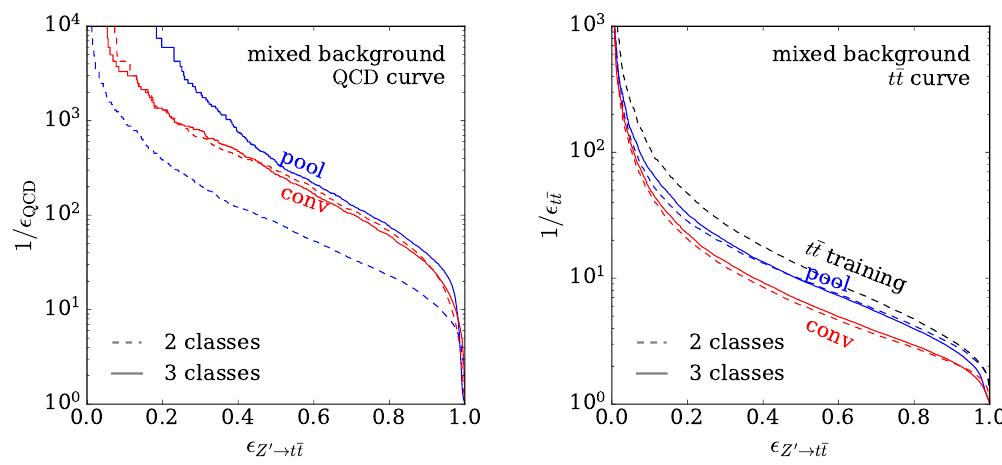
Figure 8: Left: ROC curve for the QCD di-jet background for pooling and convolu- tional CapsNets, each with two or three classes. Right: corresponding ROC curves for the continuum t ¯ t background. The t ¯ t training line quotes the best CapsNet result from Fig. 7. We always train on both backgrounds and only separate the